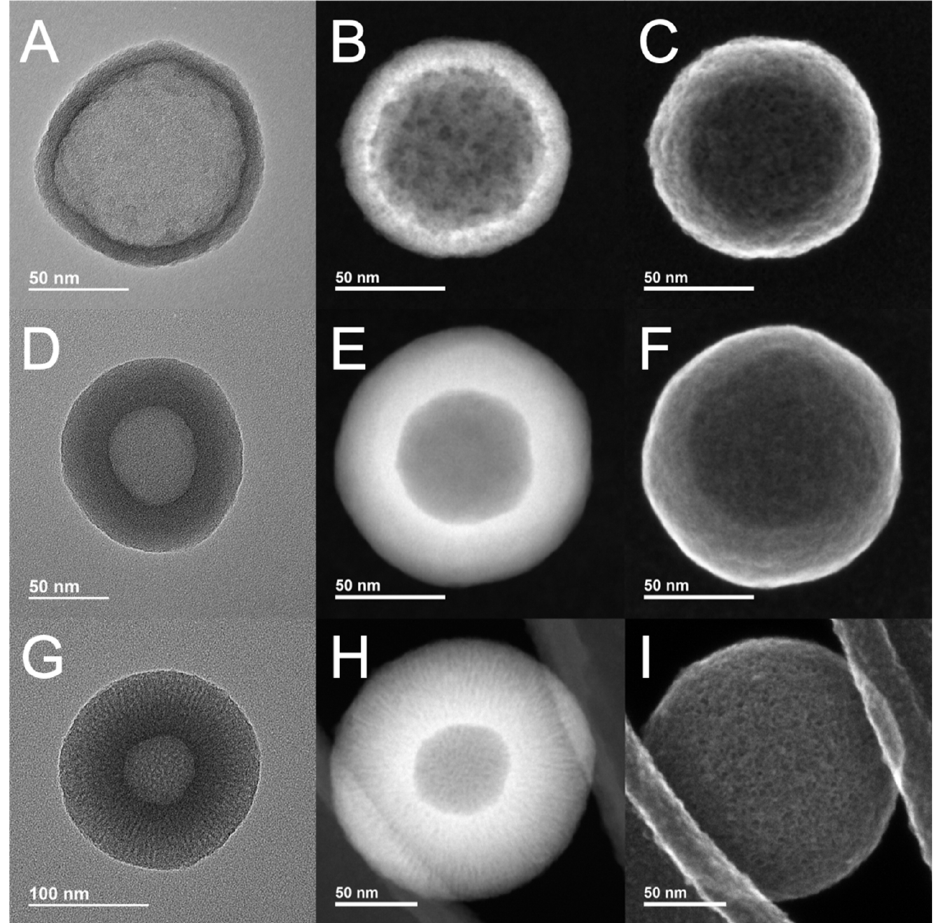
Figure 1. Electron microscopy images of fabricated nanoparticles: ( A ) TEM image of H 1 ; ( B ) STEM darkfield image of H 1 ; ( C ) STEM secondary electron image of H 1 ; ( D ) TEM image of H 2 ; ( E ) STEM darkfield image of H 2 ; ( F ) STEM secondary electron image of H 2 ; ( G ) TEM image of H 3 ; ( H ) STEM darkfield image of H 3 ; and ( I ) STEM secondary electron image of H 3 .